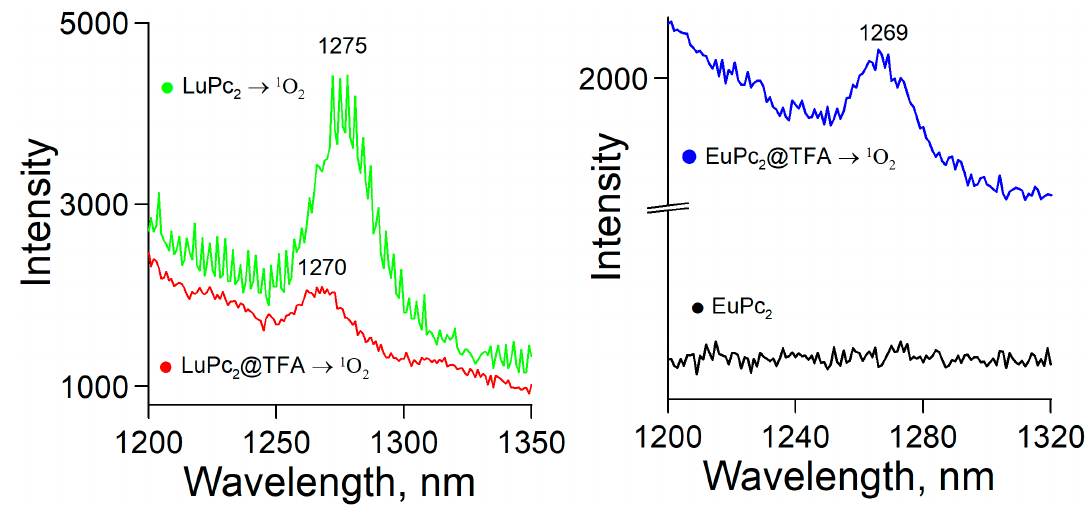
Figure 7. Singlet oxygen ( 1 Δ g ) NIR emission spectra measured in benzene for LuPc 2 , EuPc 2 and their TFA conjugates ( λ exc = 690 nm) due to 1 Δ g → 3 Σ − g transition (Scheme 1).